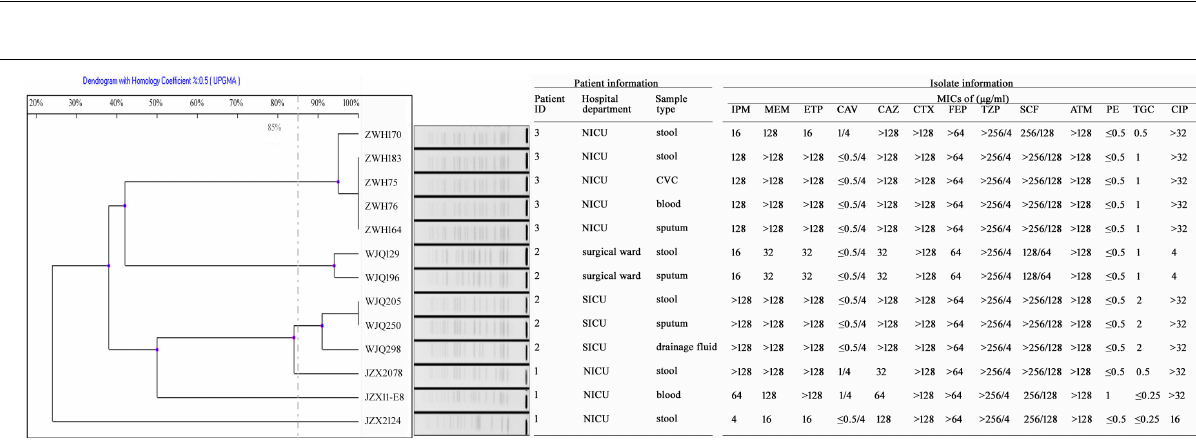
FIGURE 1 | The clinical course, therapeutic regimen, and outcomes of Patient 1 (A) , Patient 2 (B) and Patient 3 (C) who carried CRKP isolates.